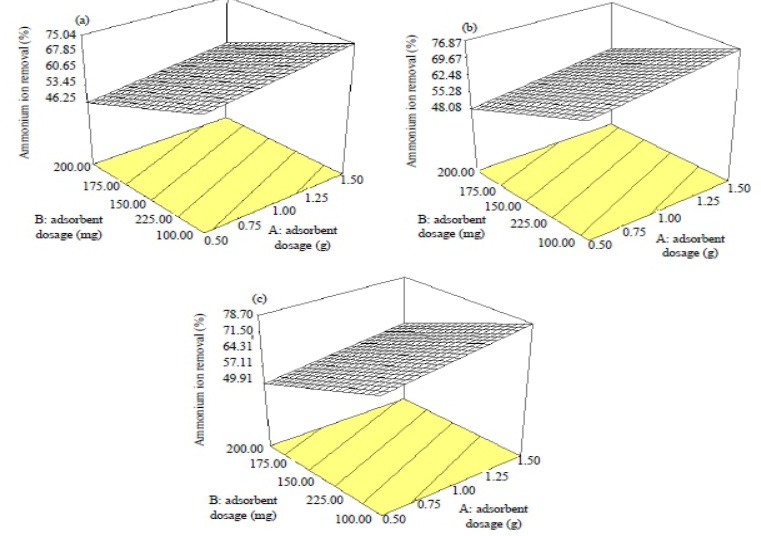
Fig. 4. Response surface plot for ammonia nitrogen removal by MCPAC at different pH: a) pH= 3, b) pH= 6 and c)